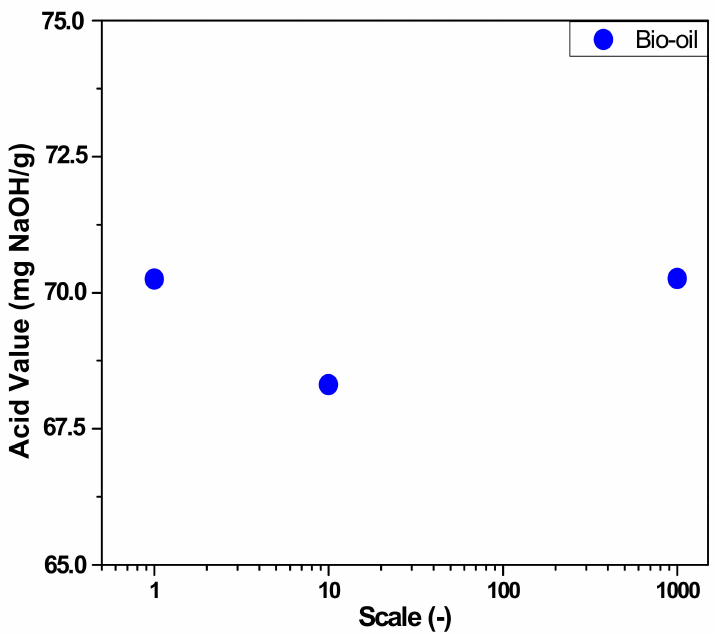
Figure 8. Acid value of bio-oil by pyrolysis of Aça í seeds pyrolysis at 450 ◦ C and 1.0 atmosphere, in laboratory, bench, and pilot